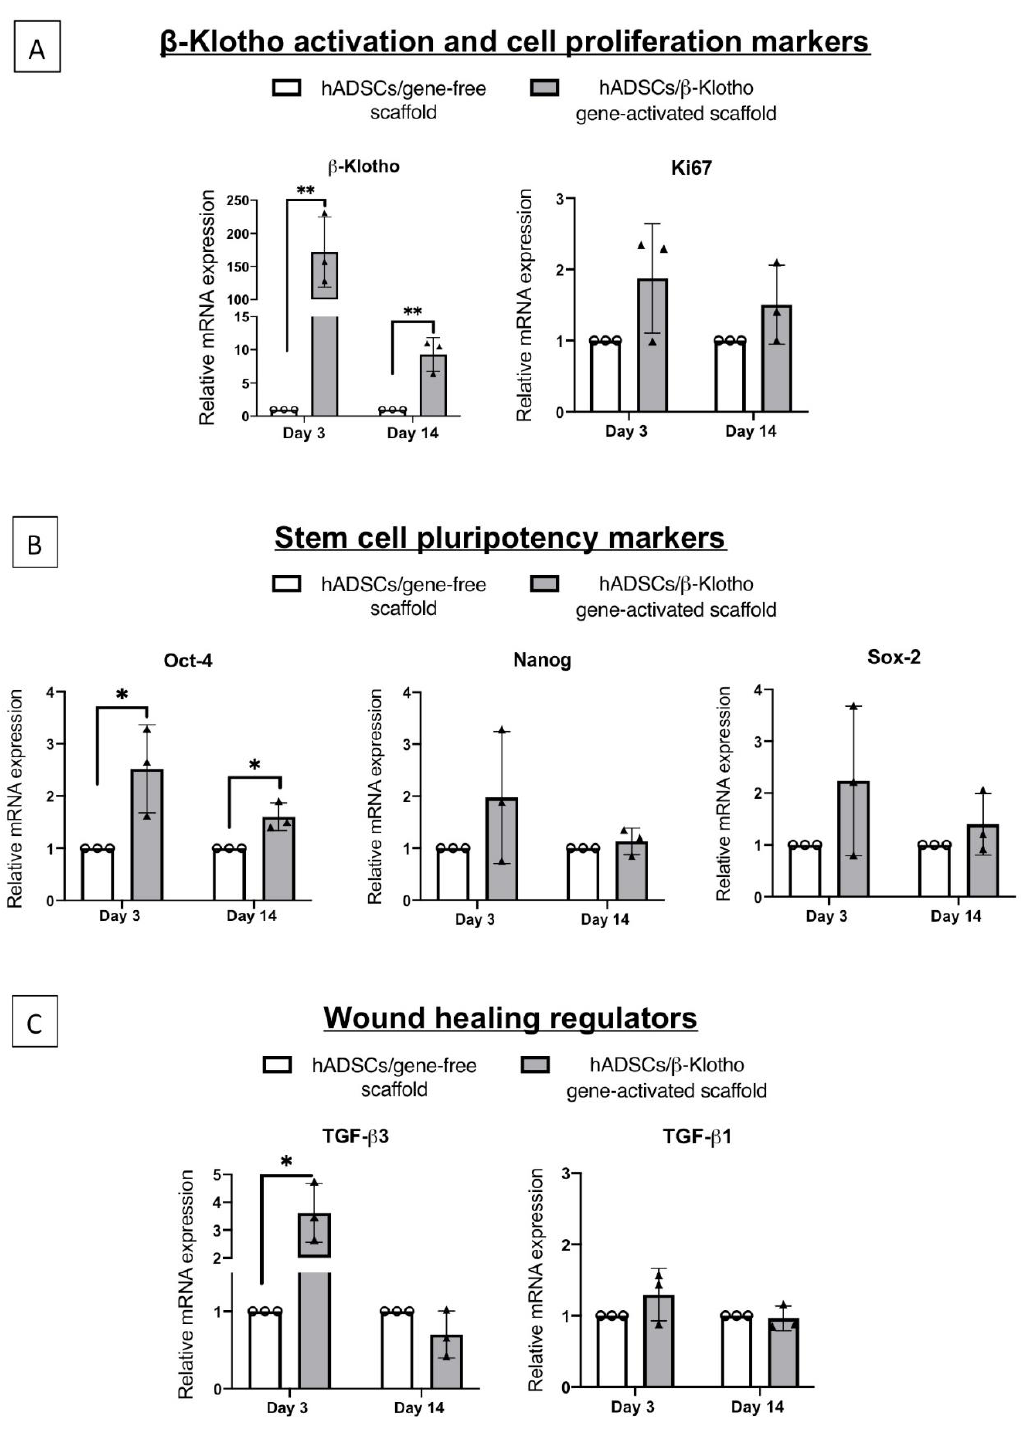
Figure 1. Transcriptional activation of functional genes in the human ADSCs by β -Klotho gene-activated scaffold on day 3 (early) and day 14 (aged). ( A ) The ADSCs on the gene-activated scaffold showed a transient, high-level overexpression of the therapeutic transgene β -Klotho until 14 days. Ki-67 marker indicates that the ADSCs proliferated well within the gene-activated scaffold. ( B ) β -Klotho overexpression significantly induced the activation of pluripotency factor Oct-4 in the ADSCs while maintaining basal levels of Nanog and Sox-2. ( C ) Increased activation of the stemness in the ADSCs was further associated with a robust early activation of the anti-fibrotic gene TGF- β 3, while maintaining basal levels of the pro-fibrotic TGF- β 1. ** and * indicates p < 0.01 and p < 0.05 respectively. Data represents mean ± standard deviation ( n = 3).